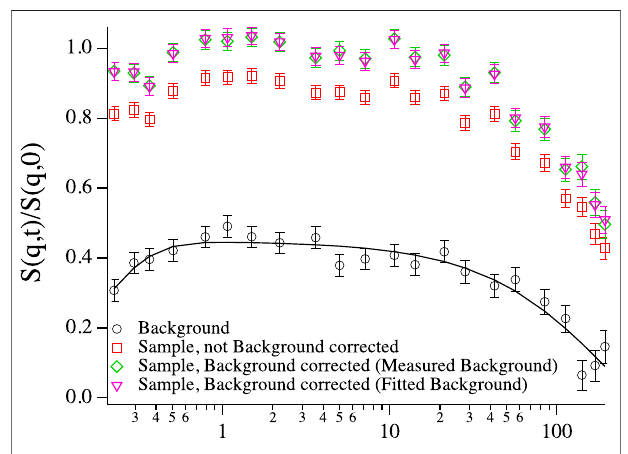
FIGURE 8 | Intermediate scattering function of vesicles at low concentration ( ∼ 1 mg/ml) at q (cid:2) 0.1 1/Å, background corrected with directly subtracted background (green diamonds), background corrected with fi tted background (purple triangles), without background correction (red squares) and the corresponding background that was subtracted from the sample to give the background subtracted data sets (black circles, black line: double exponential fi t) with fast incoherent dynamics at short times, which are still visible in the background corrected sample and background correction could not fully account for